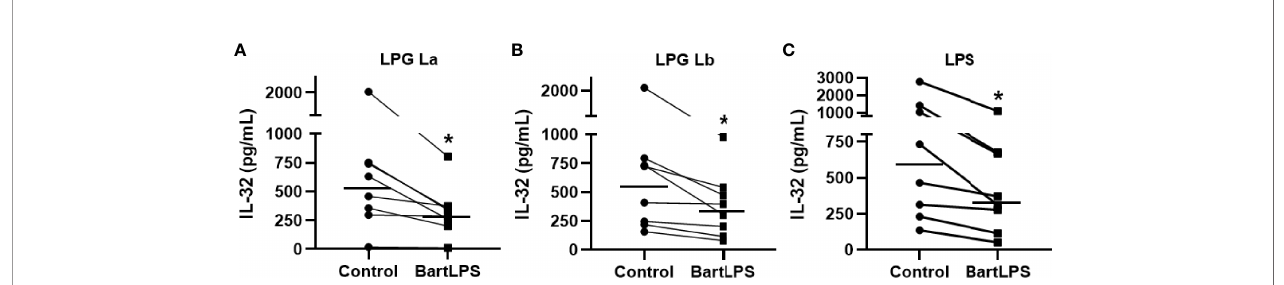
FIGURE 2 | Induction of IL-32 by lipophosphoglycans from Leishmania spp. occurs in a TLR4-dependent manner. Peripheral blood mononuclear cells (5 x 10 5 cells/200 µL) were treated or not with LPS from Bartonella quintana (BartLPS, 100 ng/ml) for 1 h. After the incubation time, cells were stimulated with LPG (10 µg/ml) of (A) L. amazonensis (La) or from (B) L. braziliensis (Lb) or (C) LPS from E. coli (100 ng/mL), for an additional 24 h. Cell lysates were obtained for IL-32 evaluation by ELISA. IL-32 production was induced by LPG of L. amazonensis (A) , L. braziliensis (B) and E. coli LPS (C) . Data represent individual measurements and median values (n = 8). *p < 0.05 (vs. control) by